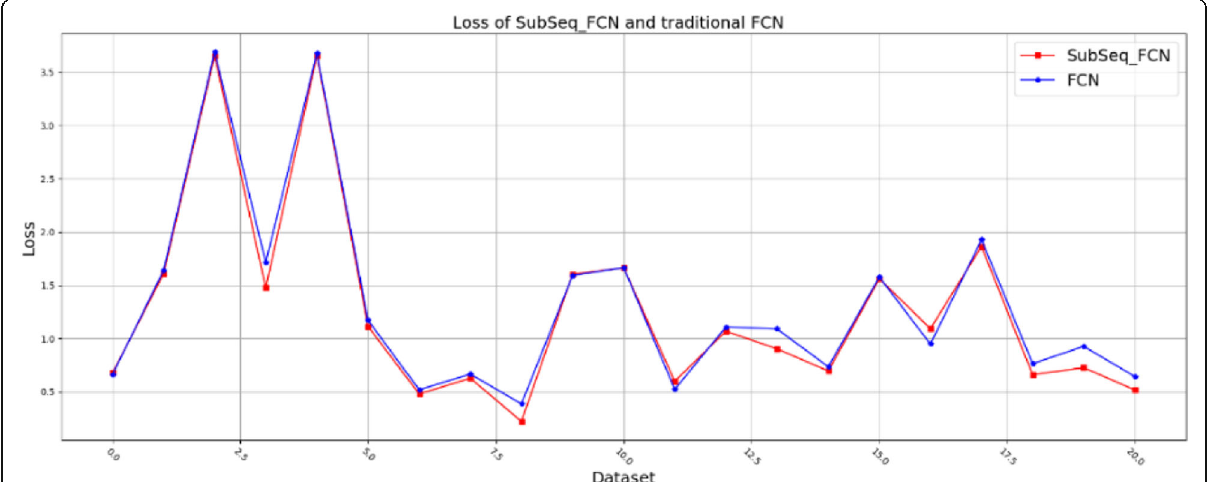
Fig. 14 Loss of SubSeq_FCN and traditional